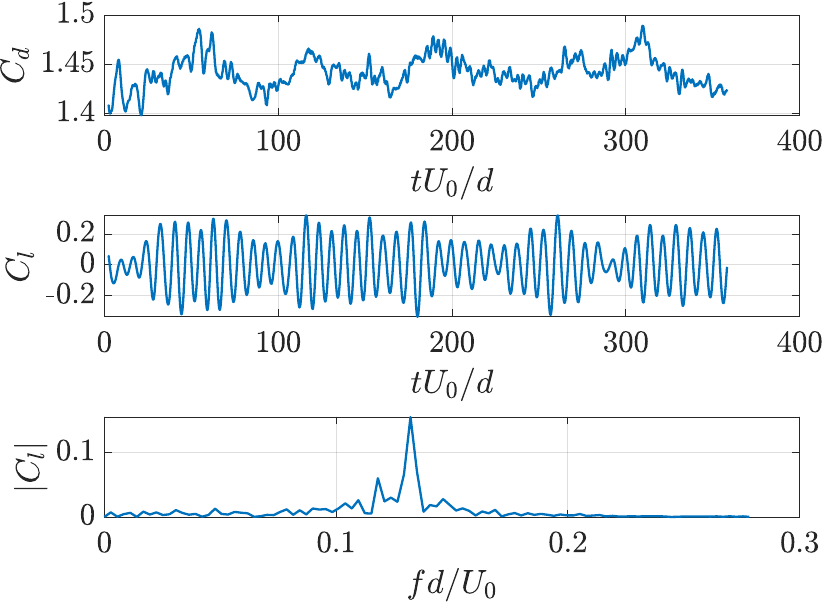
Figure 6. Time record of the drag coefficient ( top panel); time record of the lift coefficient ( middle panel); spectrum of the lift coefficient ( bottom panel). The values refer to the FSI